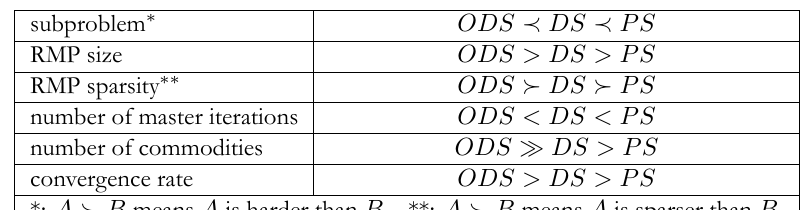
Table 1: Comparison of three DW